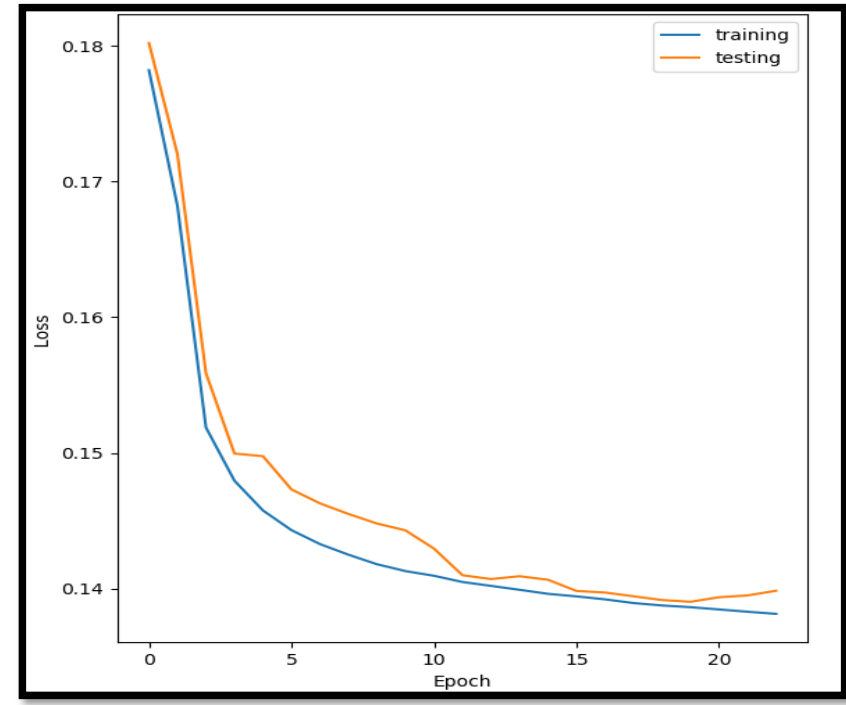
Figure 7. Training and testing losses in 20 epochs.